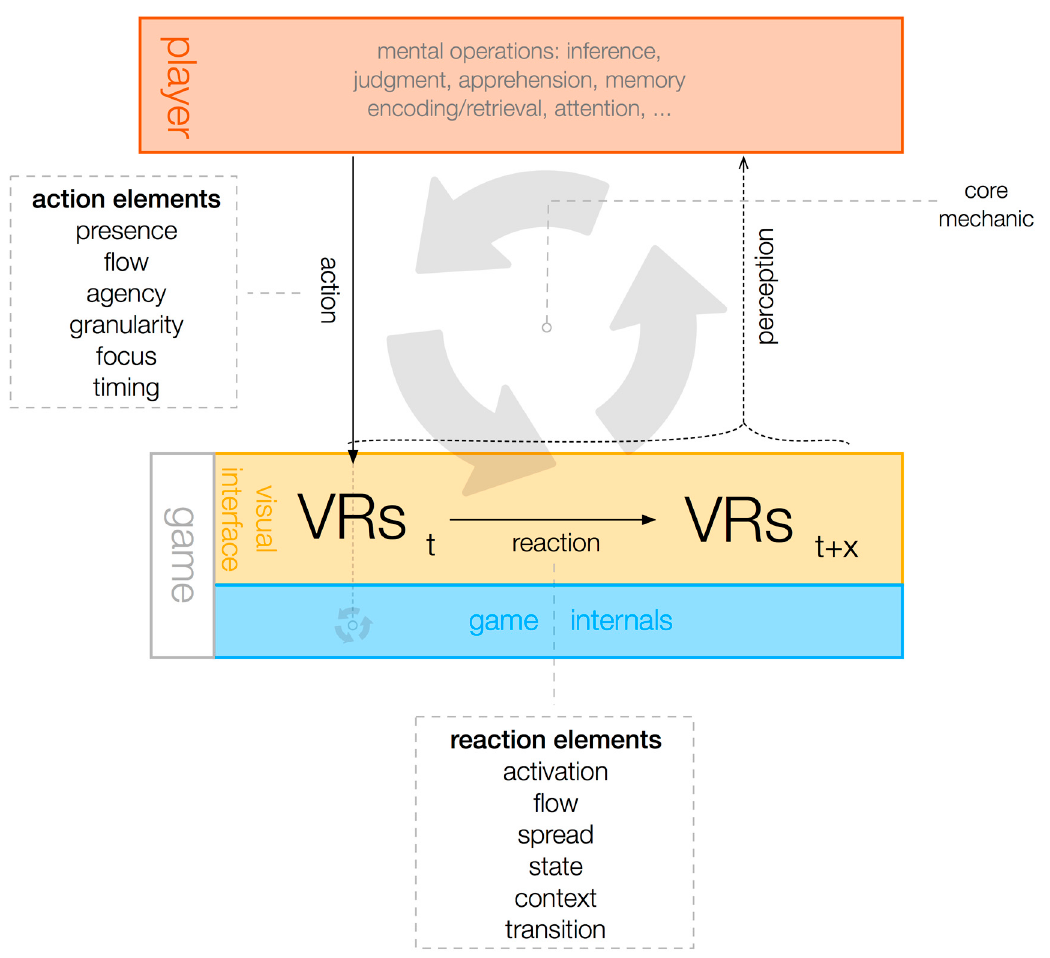
Figure 2. Depiction of the process of playing a game: a player performs an action on representations in the visual interface; representations change as a reaction; the player perceives the interface and performs mental operations throughout. VR stands for visual representation.